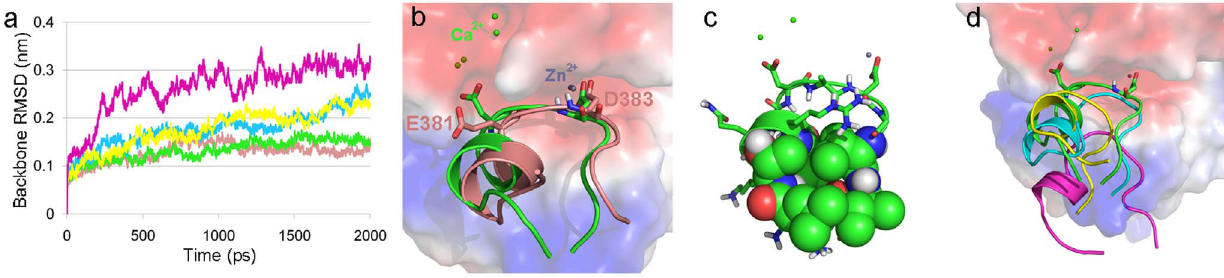
Figure 2. Comparison of the binding of loop peptides at the pseudo-active site of Shh. (a) RMSD plots for Shh backbone during 2 ns MD simulations for following complex structures: Shh-Hhip L2 complex with all metal ions, salmon; Shh-PL2 with all metal ions, green; Shh-PL2 with no zinc ion, yellow; Shh-PL2 with no calcium ions, cyan; Shh-PL2 with no metal ions, magenta. All loop structures also painted according to the colors of RMSD plots. (b) Superimposition of final snapshots of the Shh-Hhip L2 and Shh-PL2 complexes. Electrostatic potential surface was calculated from the Shh of Shh-PL2 structure. The zinc and calcium ions are shown as bluish-gray and green spheres. (c) The PL2 forming hydrophobic residues are shown by the space-filling model. (d) Superimposition of all complex structures of the Shh-PL2 with different composition of the metal ions. Electrostatic potential surface was calculated from the Shh of Shh-PL2 structure.